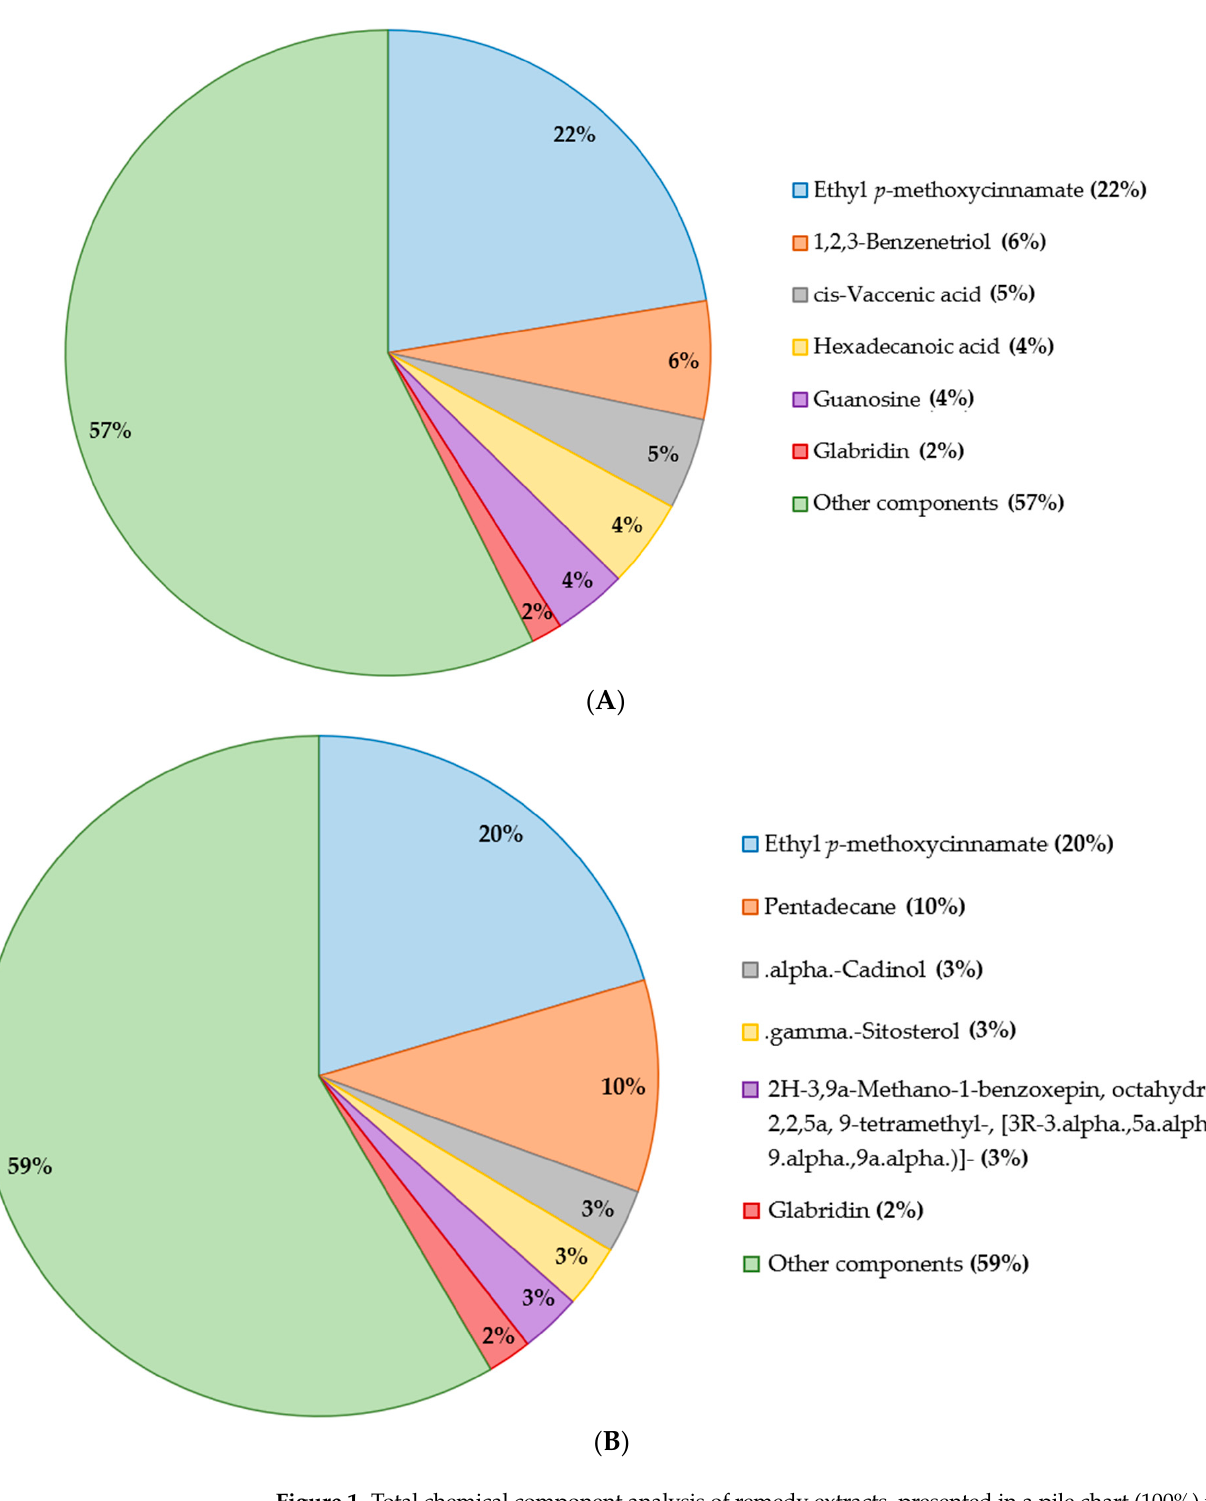
Figure 2. The chemical structures of ( A ) ethyl- p -methoxycinnamate, ( B ) glabridin, and ( C ) kojic acid. In the chemical analysis here, with earlier anti-tyrosinase activity (Table 2), glabridin was an active metabolite showing an intense anti-mushroom tyrosinase activity with an IC 50 value of 0.08 µg/mL. Therefore, the authors decided to con fi rm only the presence of glabridin in 80% ethanol and ethyl acetate extracts using high-performance liquid column chromatography (HPLC) compared to a standard reference as further analysis. 2.2.2. HPLC Analysis The authors performed an HPLC analysis to con fi rm the presence of glabridin in both 80% ethanolic and ethyl acetate extract found in the GC–MS analysis earlier. Figure 3 showed that both extracts exhibited a similar peak at a retention time of 22 min under the photodiode array (PDA) detection at 230 nm to the glabridin standard peak. Therefore, based on the HPLC analysis, the authors con fi rmed the presence of glabridin in both 80% ethanolic and ethyl acetate extract from the selected remedy, which was in agreement with the previous GC–MS analysis.